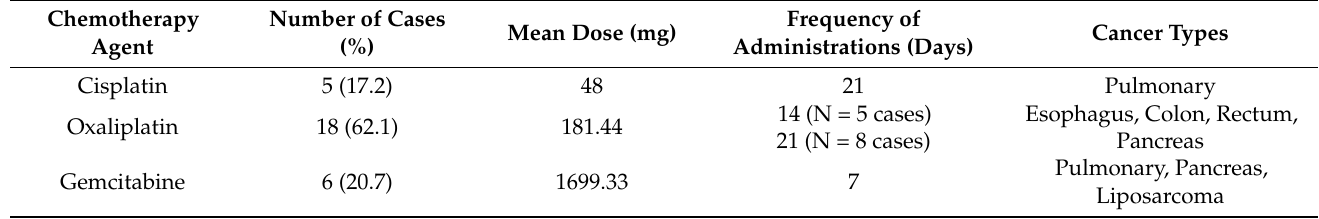
Table 1. Lot distribution regarding chemotherapy treatment, dosage, frequency and cancer types.